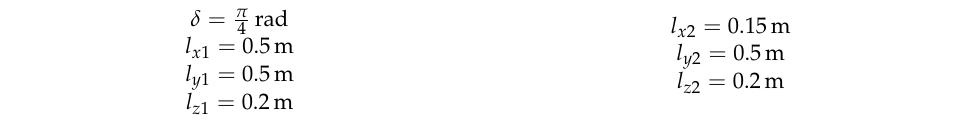
Table 5. The thrusters’ configuration parameters.